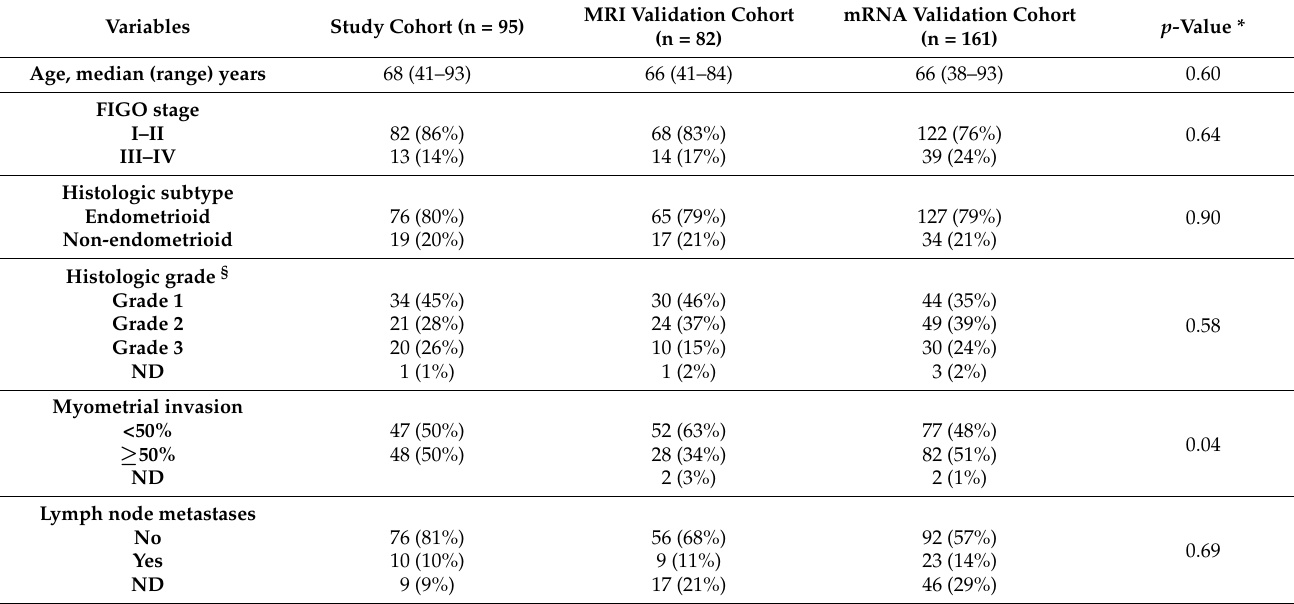
Figure 1. Pipeline for study design and patient cohorts. MRI, magnetic resonance imaging; LASSO, least absolute shrinkage and selection operator; ADC, apparent diffusion coefficient. Table 1. Patient and tumor characteristics for the study cohort (having both magnetic resonance imaging (MRI) and mRNA data), MRI validation cohort, and mRNA validation